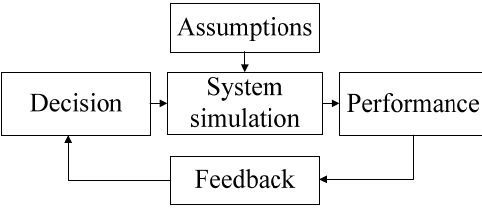
Figure 5. Evaluation model of system simulation.